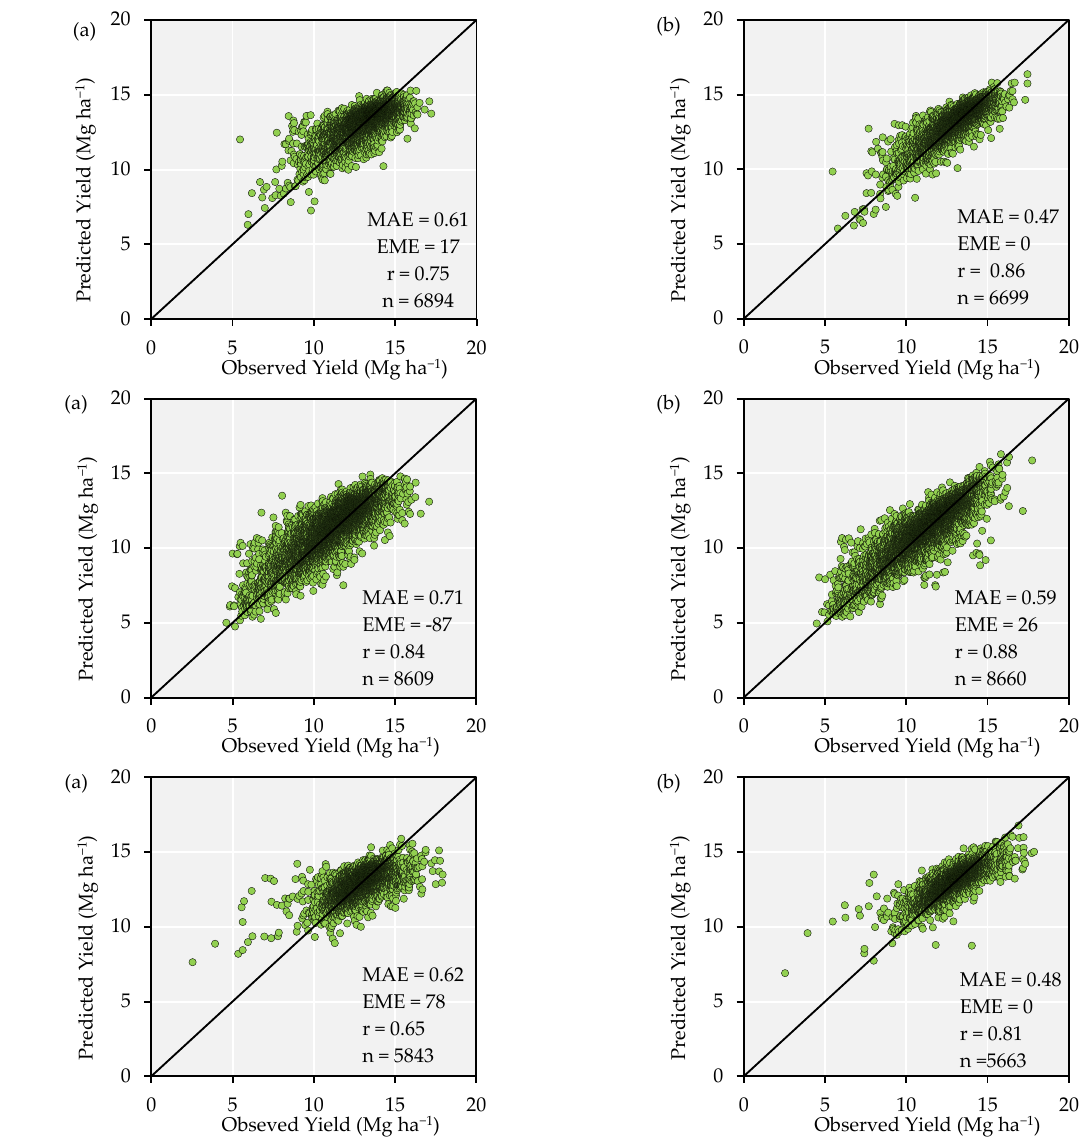
Figure 13. Performance analysis of test dataset with the features spectral bands + TPI + TWI in two approaches of model calibration, ( a ) whole-field and ( b ) site-specific models, in the scenario of the season 2018. Observation: MAE (mean absolute error) is expressed in Mg ha −1 , EME (estimative mean error) in Kg ha −1 , and r is the correlation coefficient.